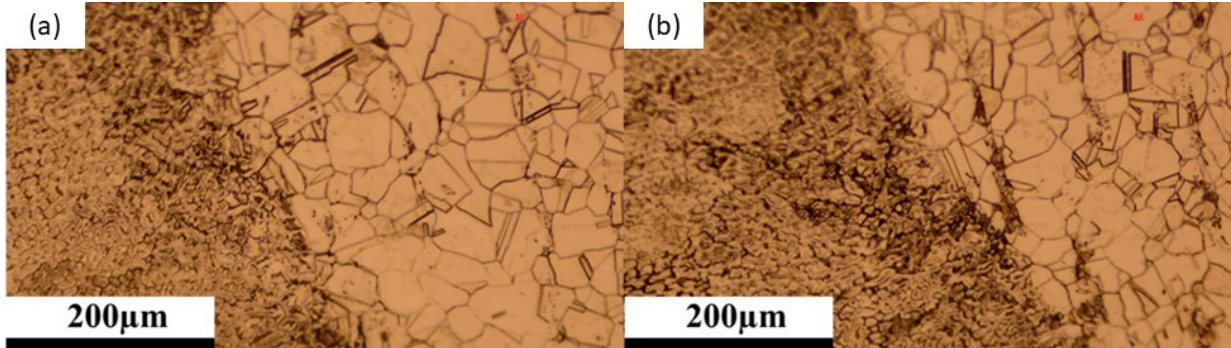
Figure 16. Microstructure of 316L stainless steel. ( a ) Before regulation; ( b ) After